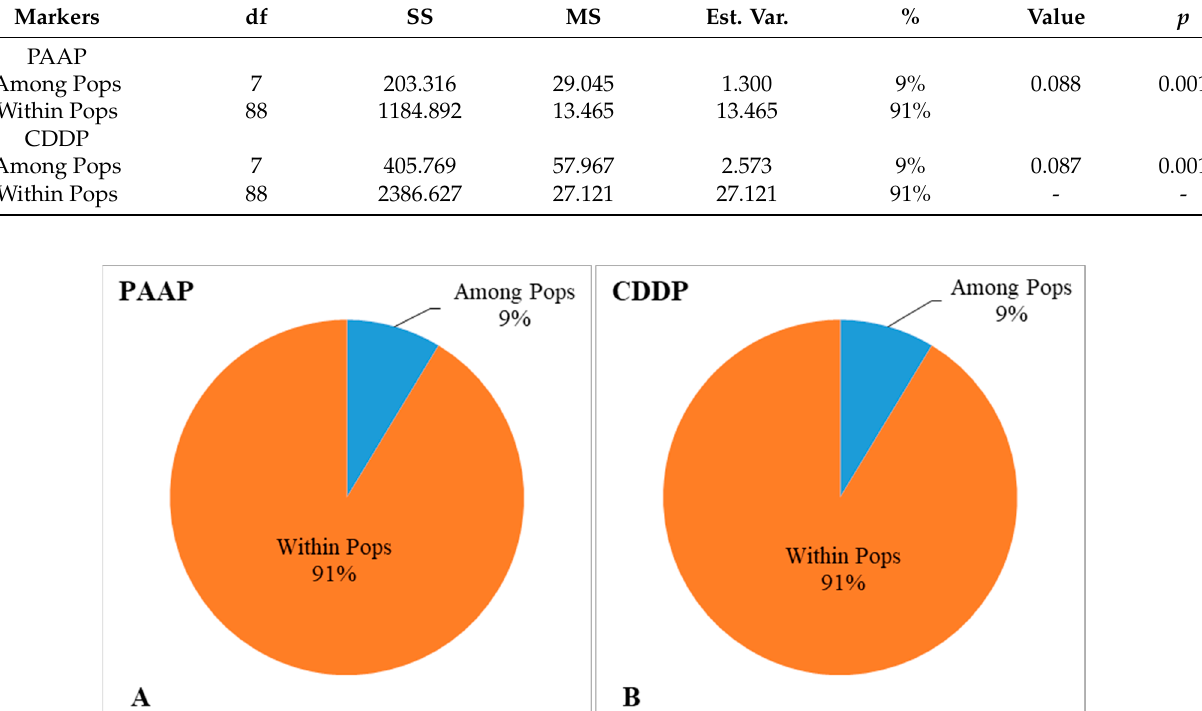
Figure 4. Analysis of molecular variance (AMOVA). AMOVA based on PAAP markers ( A ), AMOVA based on CDDP markers ( B ).